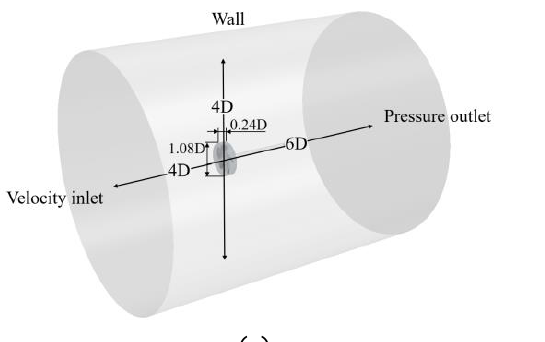
Figure 5. Mesh independence analysis of propellers Kap01 ( a ) and Kap04 ( b ) related to the base size of mesh.